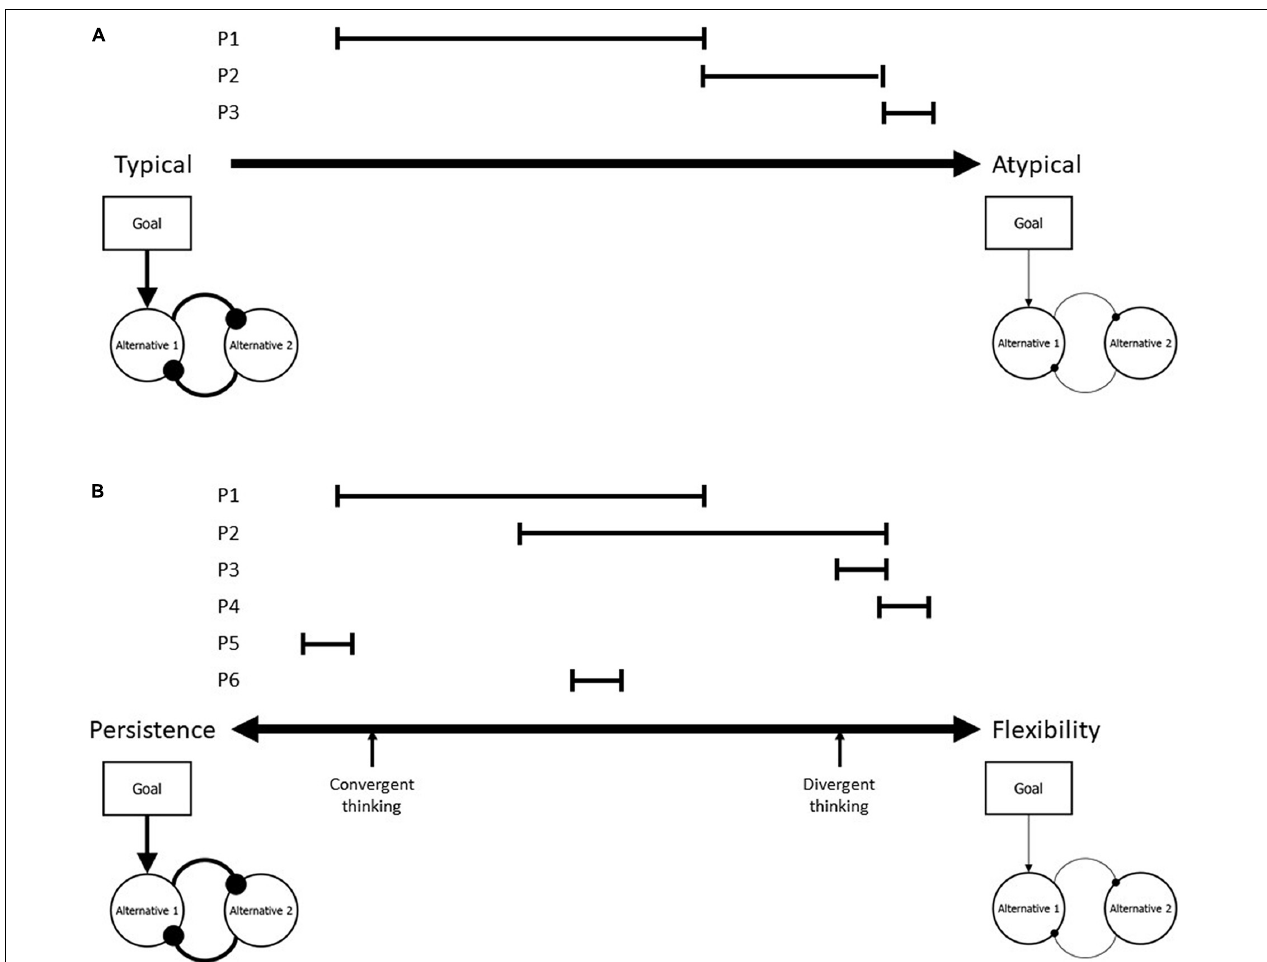
FIGURE 1 | The implications of the classical unipolar view on psychiatric conditions (A) and the bipolar alternative developed in this article (B) . (A) Considers the average functioning of individuals as “typical” or “normal,” based on population means, and systematic deviation from these means as “atypical” or “deviant.” According to this logic, individual performance with a range exhibited by P1 would be likely to be diagnosed as typical, performance exhibited by P2 as borderline, and performance shown by P3 as sufficiently deviant to be psychiatrically relevant. The figures below the origin and the endpoint of the dimension characterize the processing style assessed by typical cognitive-control tasks, which are commonly biased toward persistence. Accordingly, persistent individuals have a higher probability to be considered typical than more flexible individuals. (B) Keeps these processing characteristics but turns the unipolar dimension into a truly bipolar, ranging from persistence to flexibility, with no evaluative meaning attached to either pole. P1–P6 characterize performance variability of individuals, as described in the text. Note that persistence is considered to be beneficial for some tasks, such as convergent thinking, while flexibility is considered to be beneficial for other tasks, such as divergent